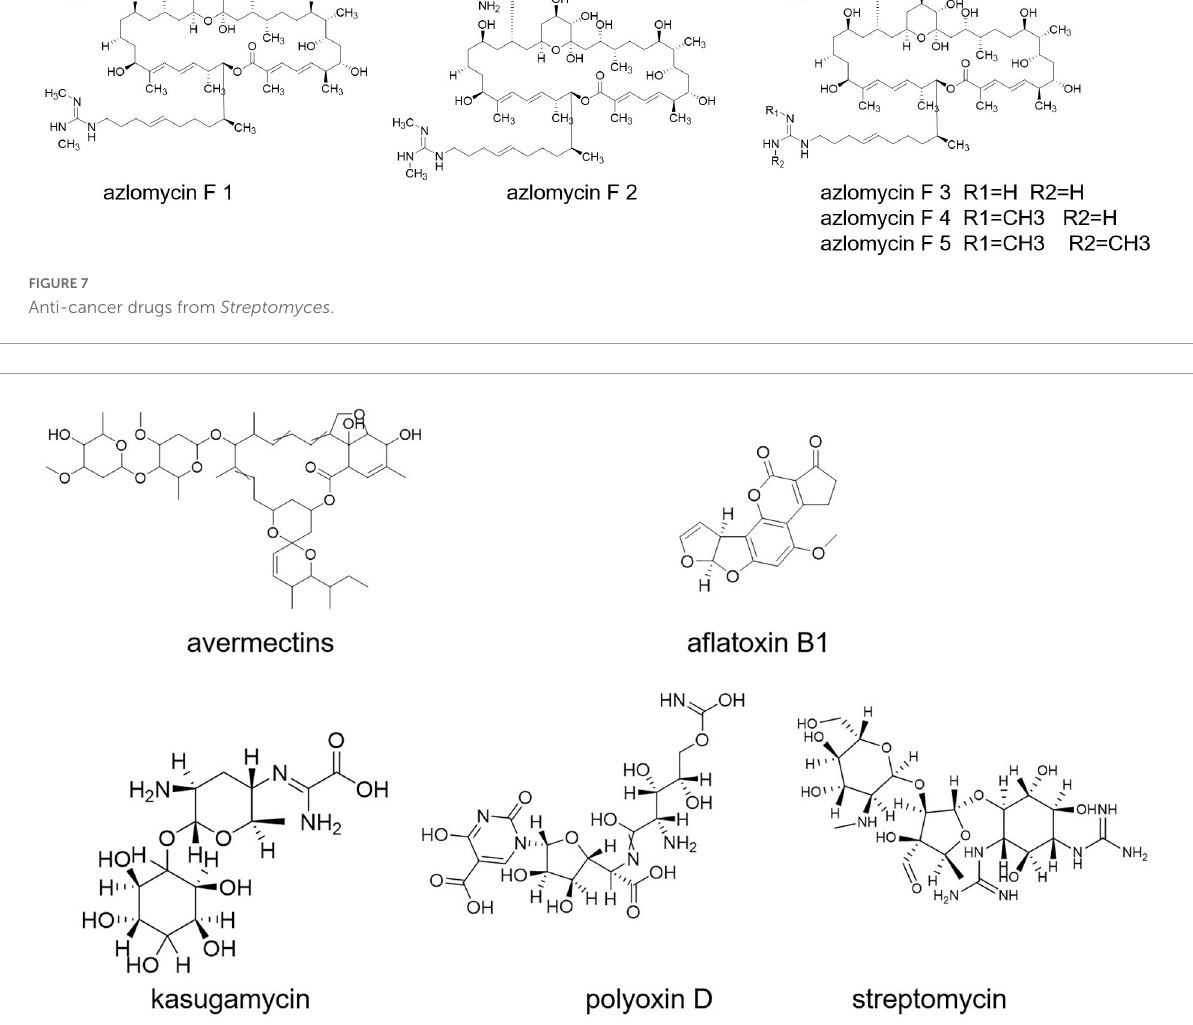
FIGURE8 Insecticides, pesticides and herbicides